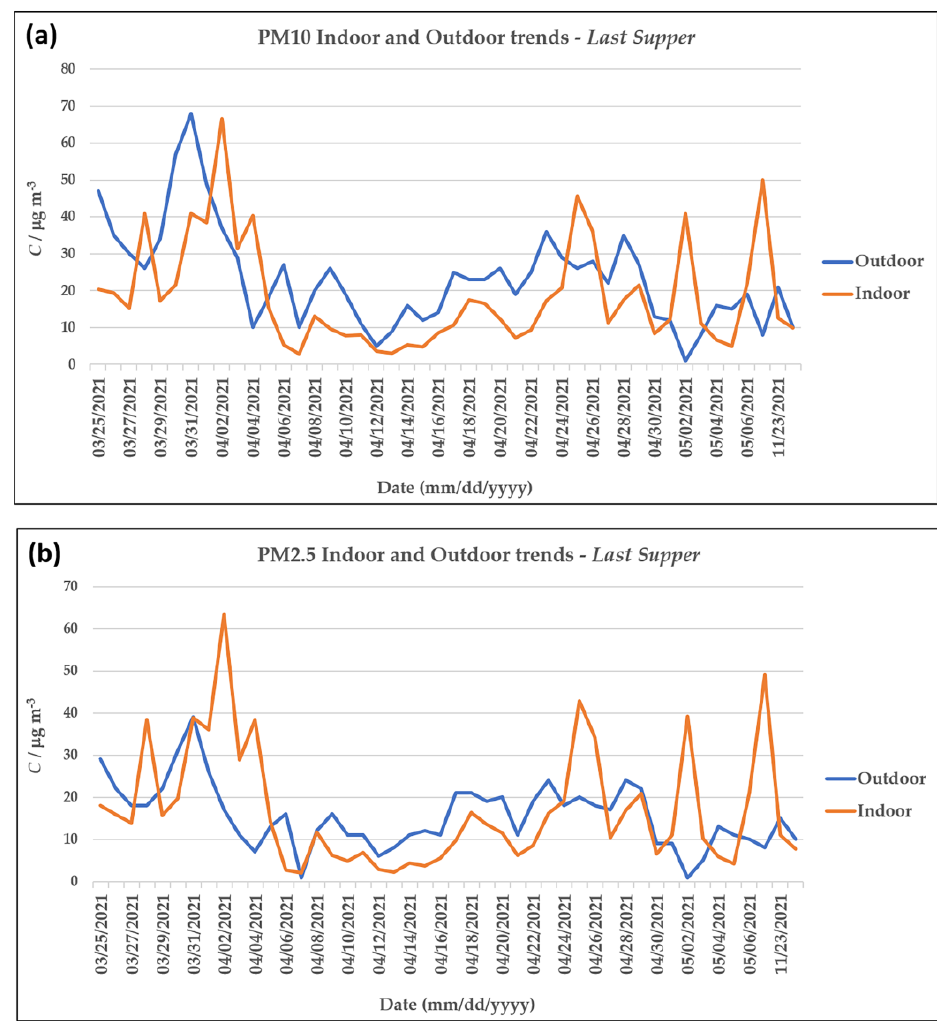
Figure 4. ( a ) The PM10 and ( b ) PM2.5 indoor and outdoor trends for the sampling site at the Last Supper